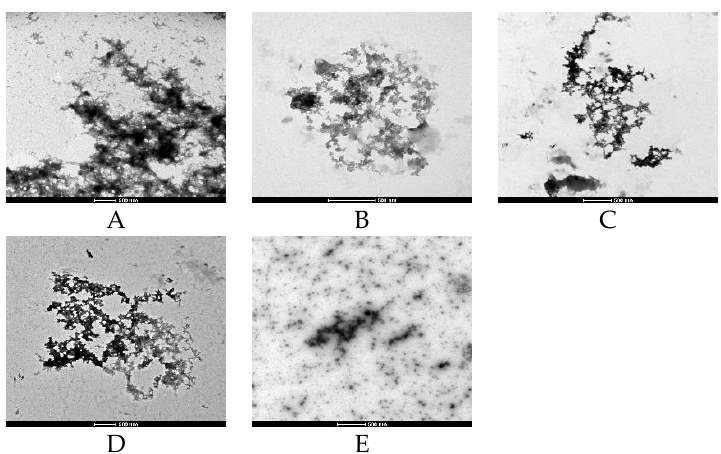
Figure 5. Representative transmission electron micrographs demonstrating effects of each tea extract (100 µ g / mL) on A β (10 µ M) fibril and aggregate formation after 48 h incubation. ( A ) A β , ( B ) GT + A β , ( C ) OT + A β , ( D ) BT + A β and ( E ) WT + A β . Scale bar: 500 nm ( A – E ).